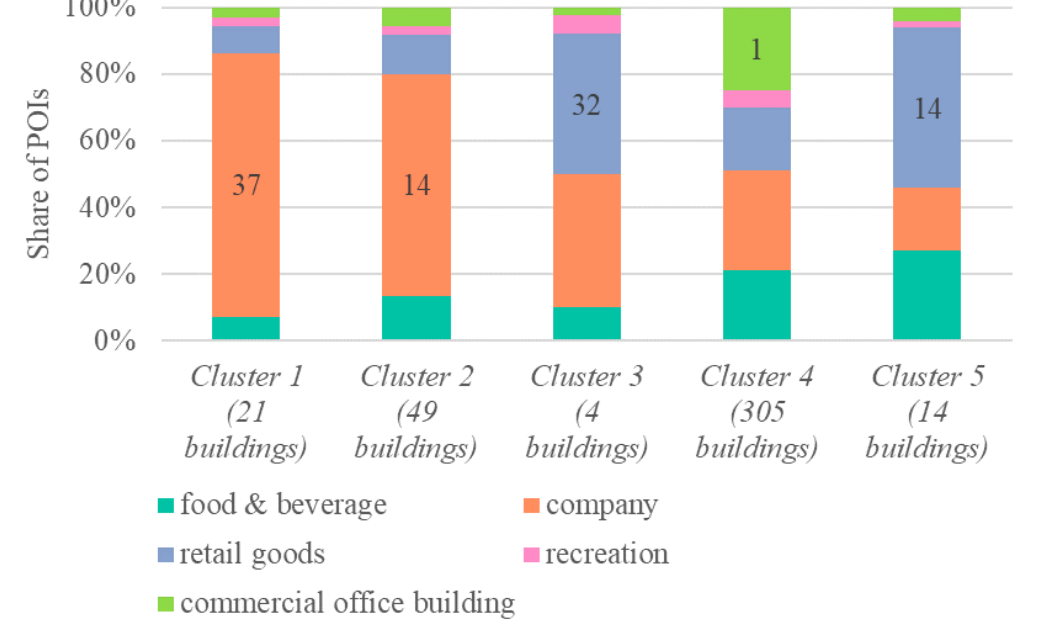
Energies 2020 , 13 , x FOR PEER REVIEW Figure 6. Commercial office buildings clustering. Figure 6. Commercial office buildings clustering.